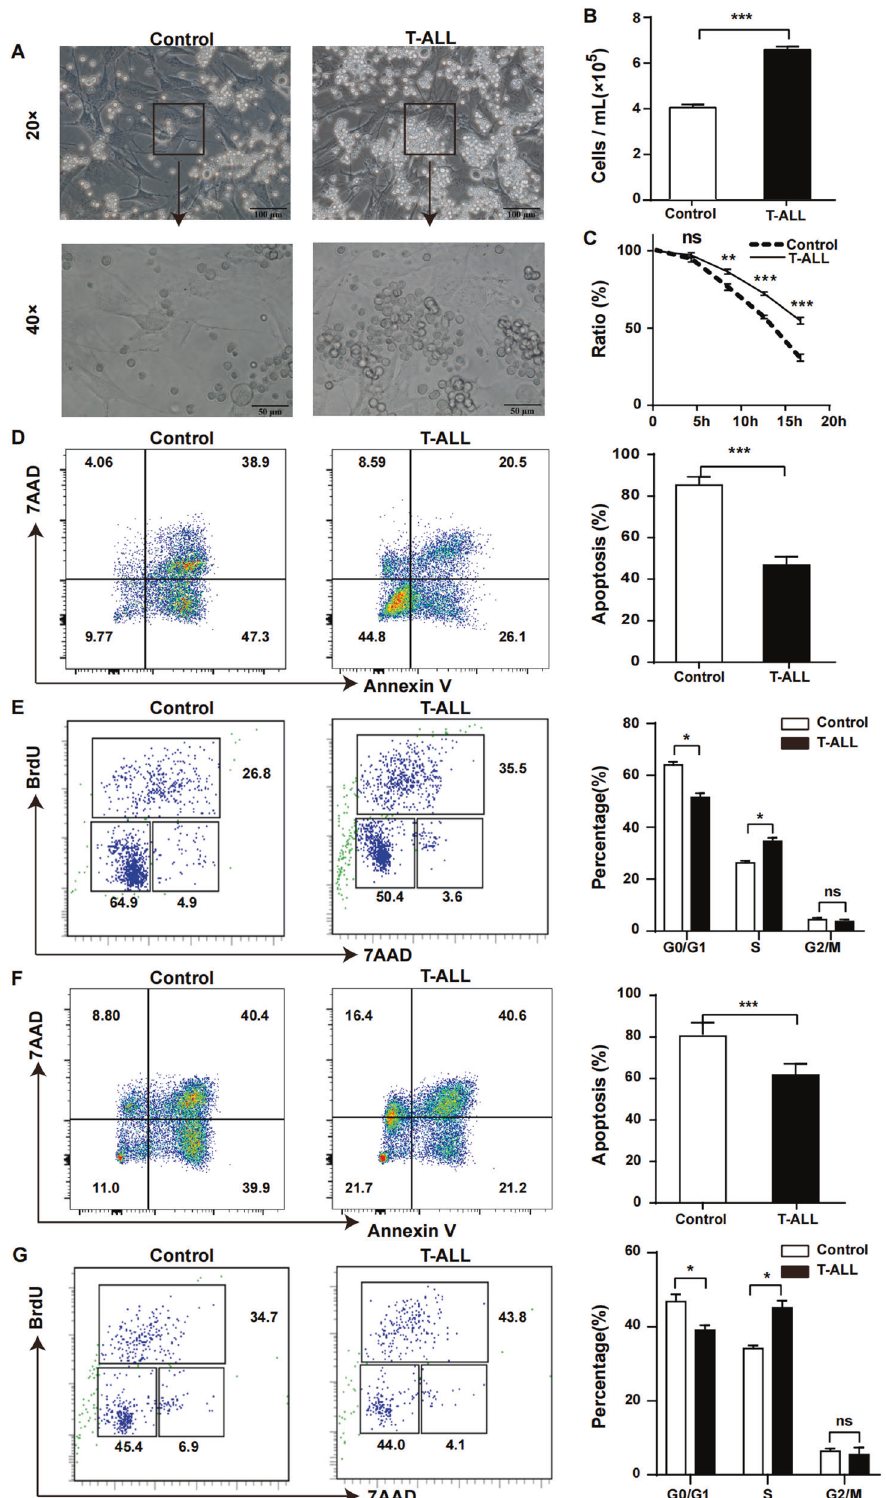
MSCs accelerated the proliferation of T-ALL cells To further determine the contribution of MSCs during T-ALL development, an in vitro co-culture system was established. Morphological images intuitively revealed that the number of surviving leukaemia cells after co-culture with leukaemia-derived MSCs for 16 h was higher compared to control group (Fig. 3A)